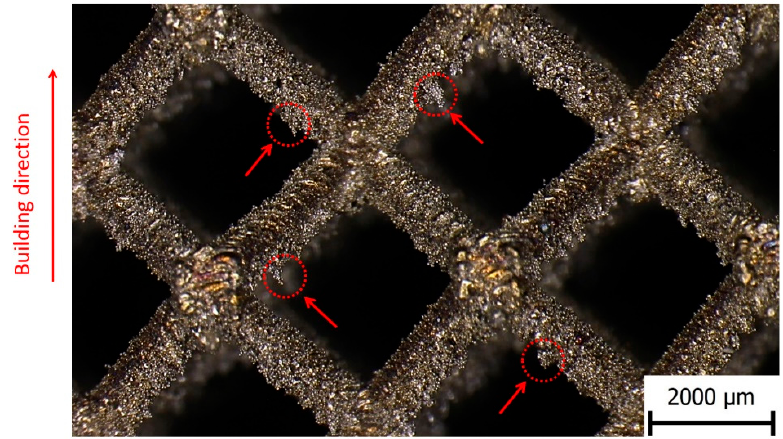
Figure 7. Detail of lattice structure surface with imperfections.